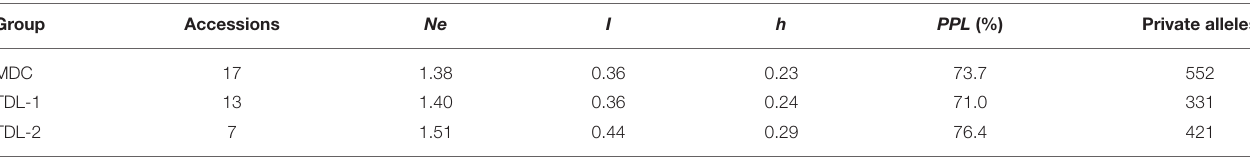
TABLE 1 | Results of AMOVA using 5,555 SNP markers and 37 durum wheats. Source of variation Degree of freedom Sum of squares Variance components Percentage of variation p values Among groups 2 4836.018 < 0.001 Within groups 34 Total